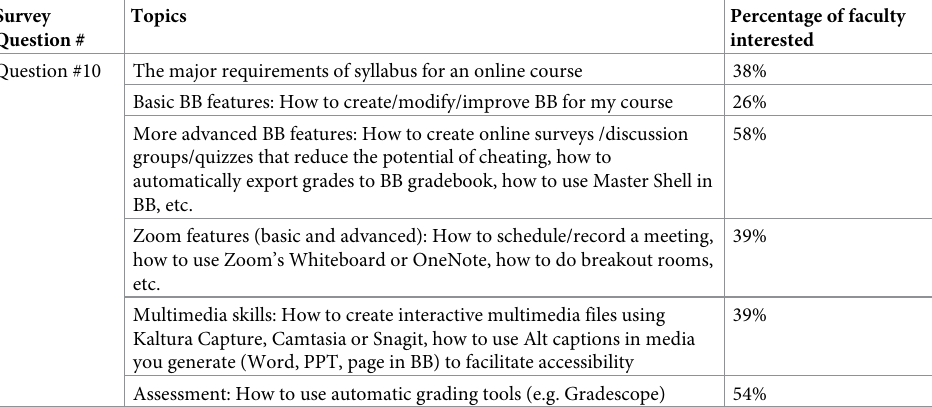
Table 2. A list of topics identified by faculty for further skill enhancement. Respondents could choose as many top- ics as they were interested to